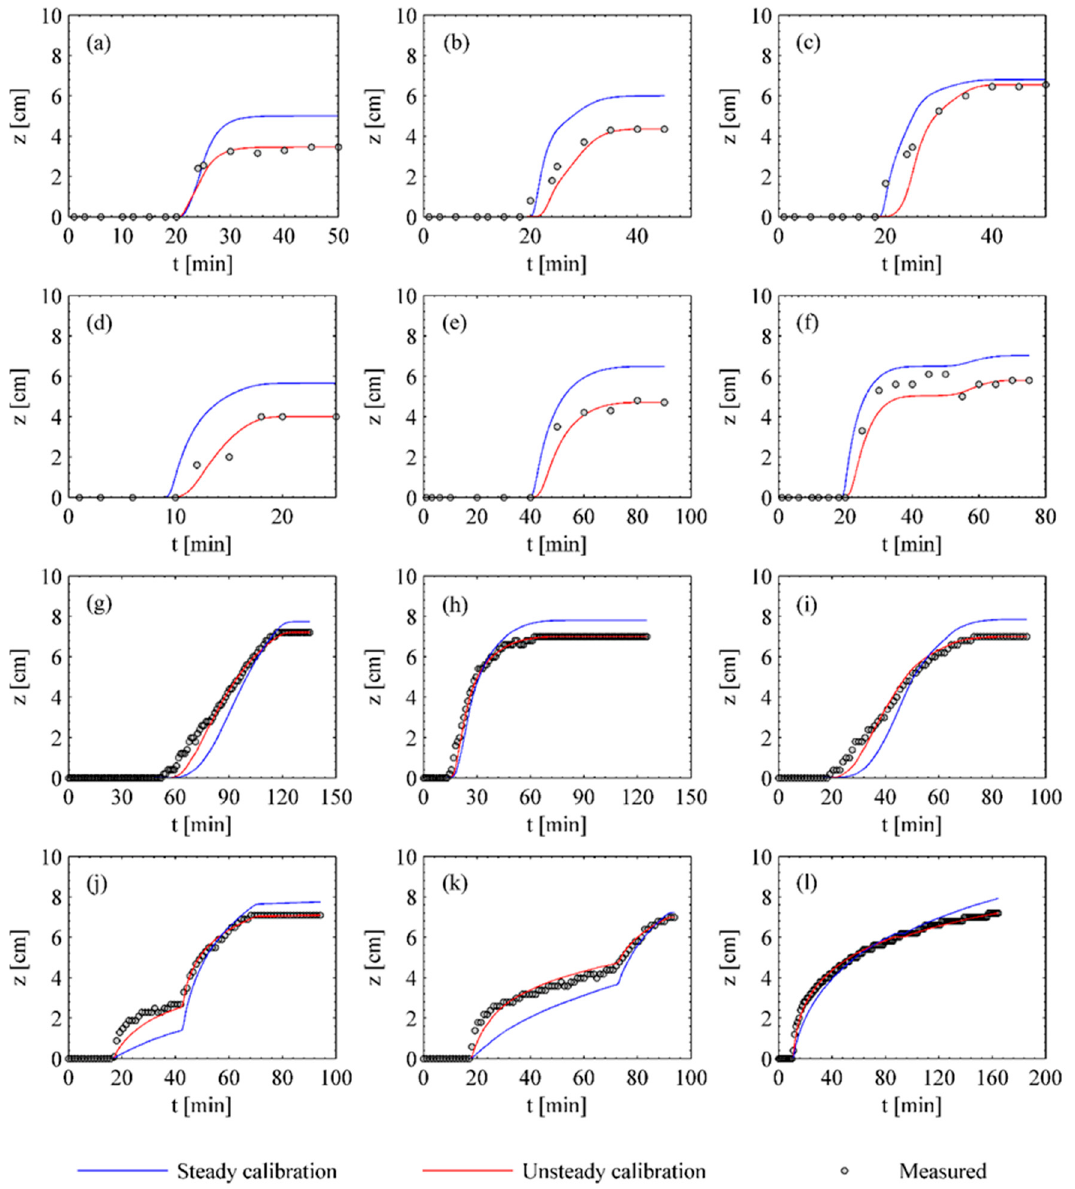
Figure 3. Benchmarking of the BRISENT model with λ calibrated with steady and unsteady runs. Images ( a – f ) are experiments 2005OLIVETO01U, 2005OLIVETO02U, 2005OLIVETO03U, 2005OLIVETO04U, 2005OLIVETO05U and 2005OLIVETO06U, respectively; images ( g – l ) are experiments 2017PIZARRO01U, 2017PIZARRO02U, 2017PIZARRO03U, 2017PIZARRO04U, 2017PIZARRO05U and 2017PIZARRO06U,